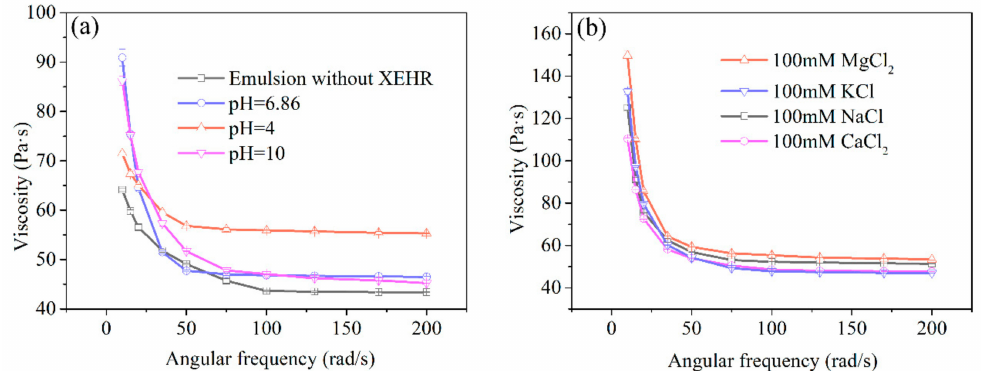
Figure 8. The viscosities of emulsions ( a ) without the XEHR and at di ff erent pH ( b ) containing various